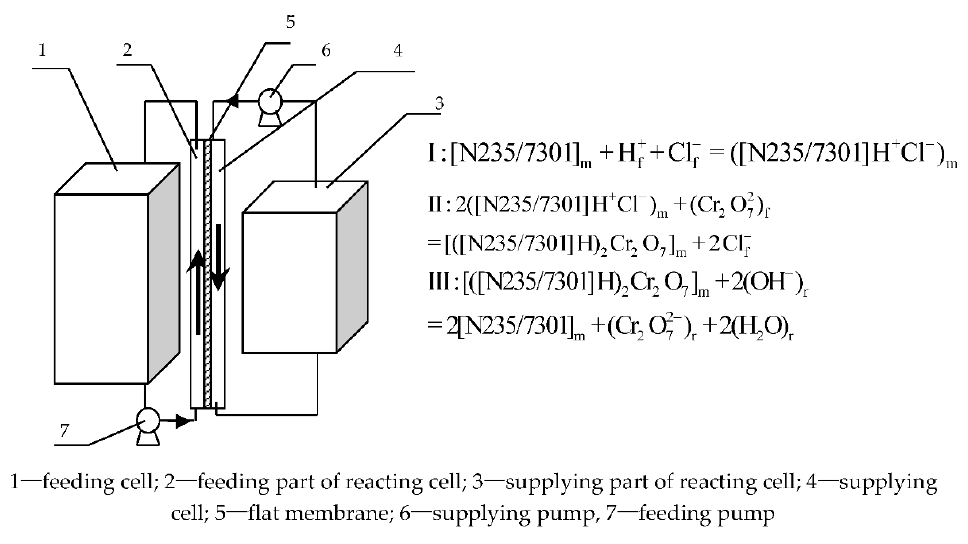
Figure 1. The structure and reaction mechanisms of the flat supplying membrane equipment (FSME) with mixed N235/7301 dissolved in petroleum and sodium hydroxide solvent for the dislodging of Cr (VI) [35].